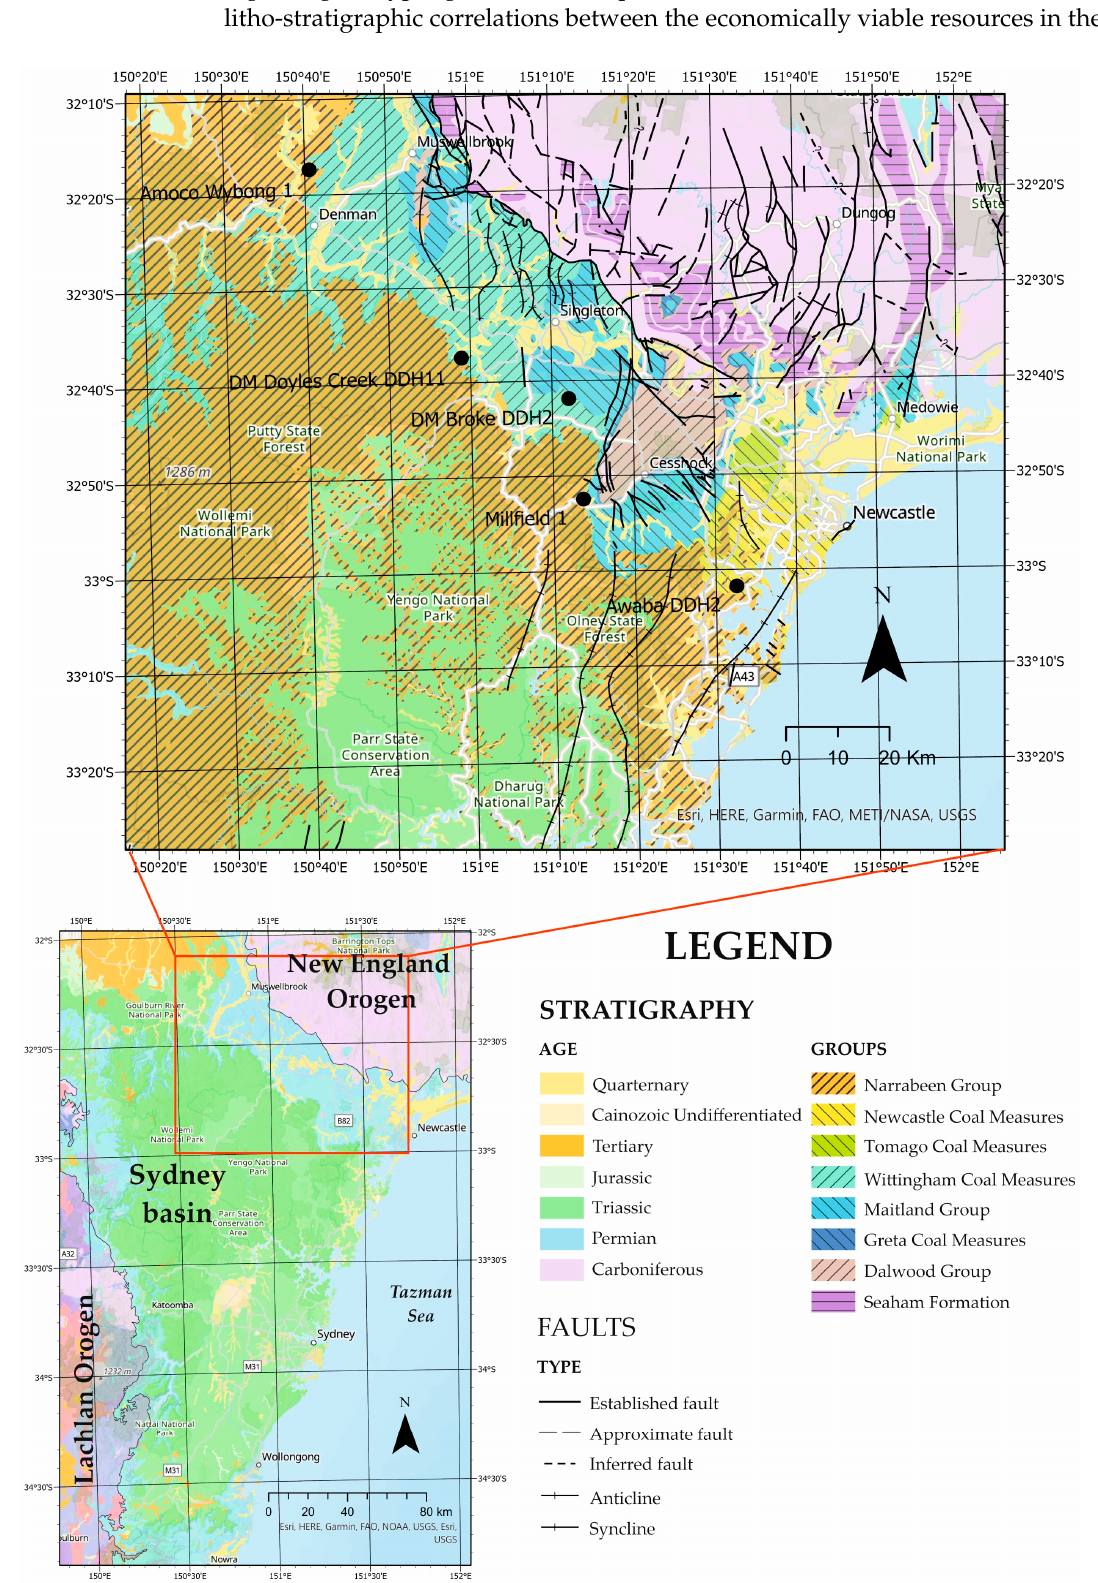
Figure 1. Geological map illustrating the Sydney Basin, bounded by the New England and Lachlan Orogens (modified from Geological Survey of